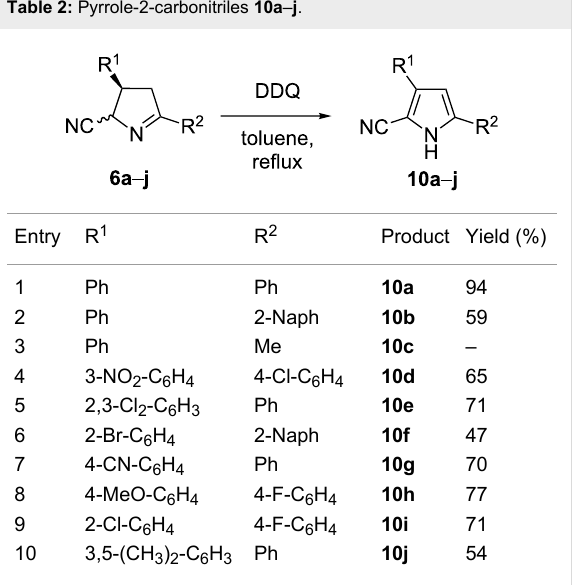
Table 2: Pyrrole-2-carbonitriles 10a – j